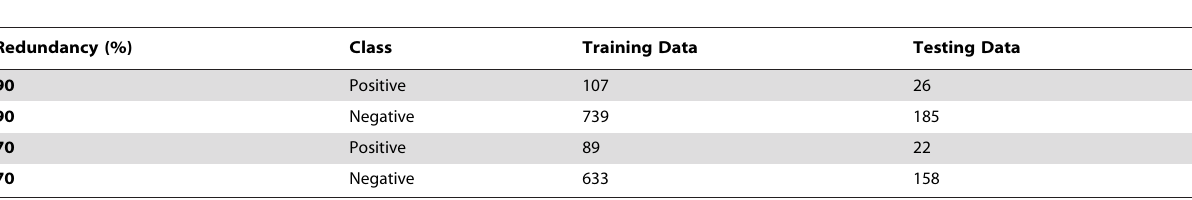
Table 2. Number of positive and negative instances in testing and training dataset.